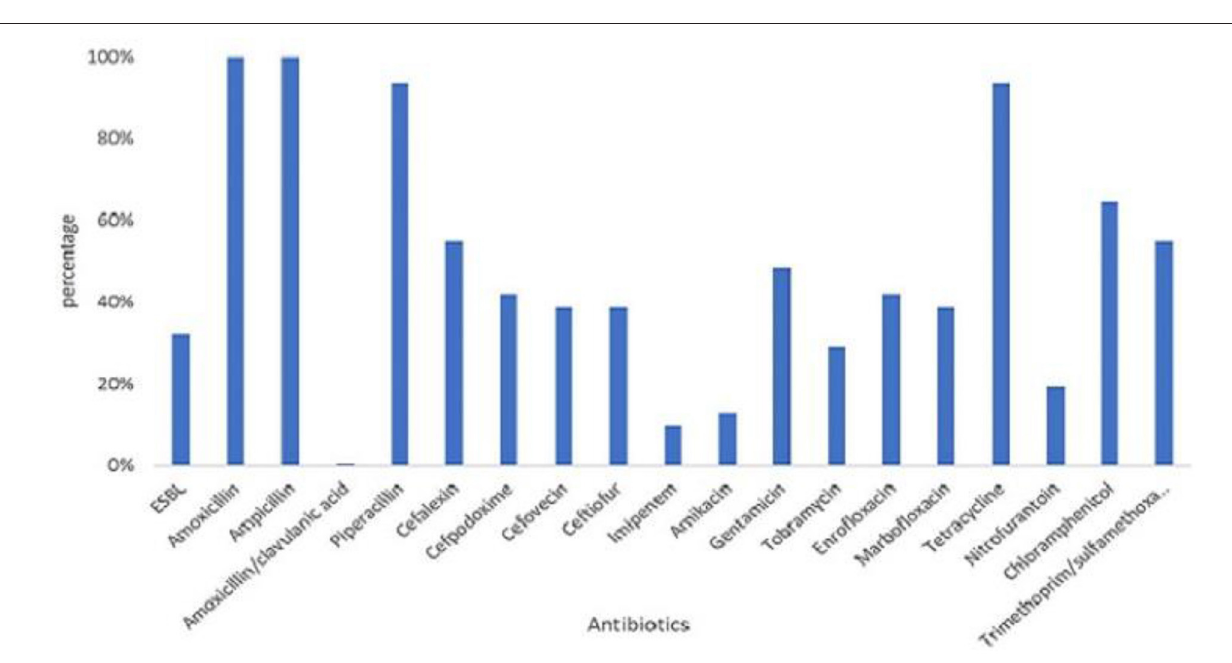
Frontiers in Veterinary Science |